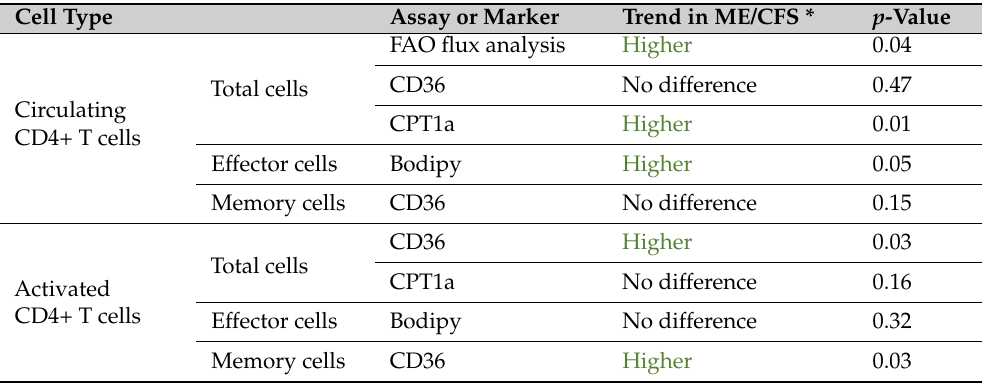
Table 3. Summary of results concerning FAO in ME/CFS vs. control CD4+ T cells. Cell